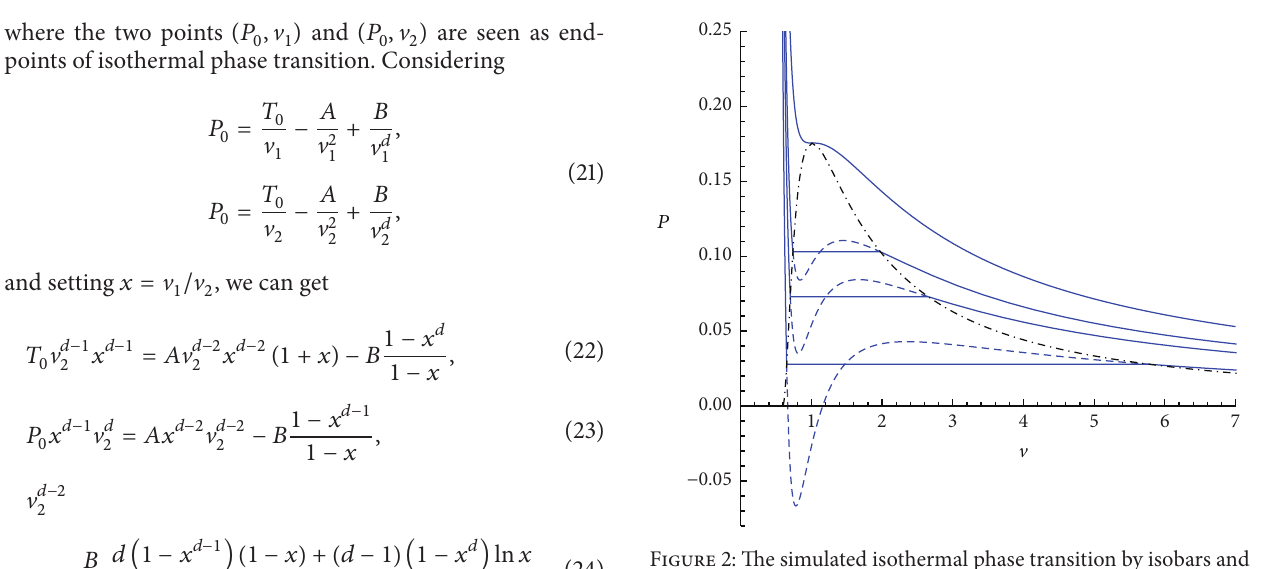
Figure 2: The simulated isothermal phase transition by isobars and the boundary of two-phase coexistence region for the topological dilaton black hole as 𝑛 = 5, 𝑏 = 1, 𝑄 = 1, 𝛼 = 0.01